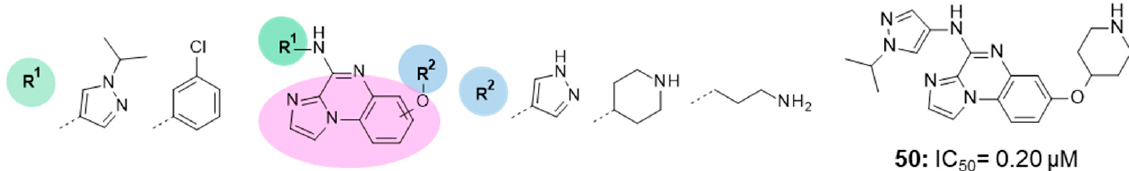
Figure 10. Fyn inhibitors based on 4-amine-imidazo[1,2- a ]quinoxalin scaffold (magenta) exploring different 4-amino (green) and 6 or 7-ethyl (cyan) substituents by Paraselli et al. [132]. Table 2. ATP-competitive FYN inhibitors and their applications.